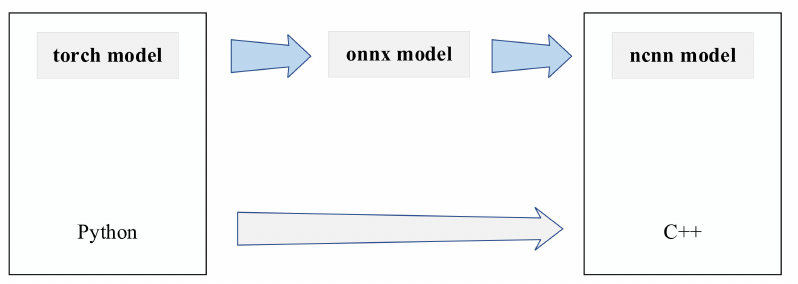
Figure 7. Model conversion schematic.